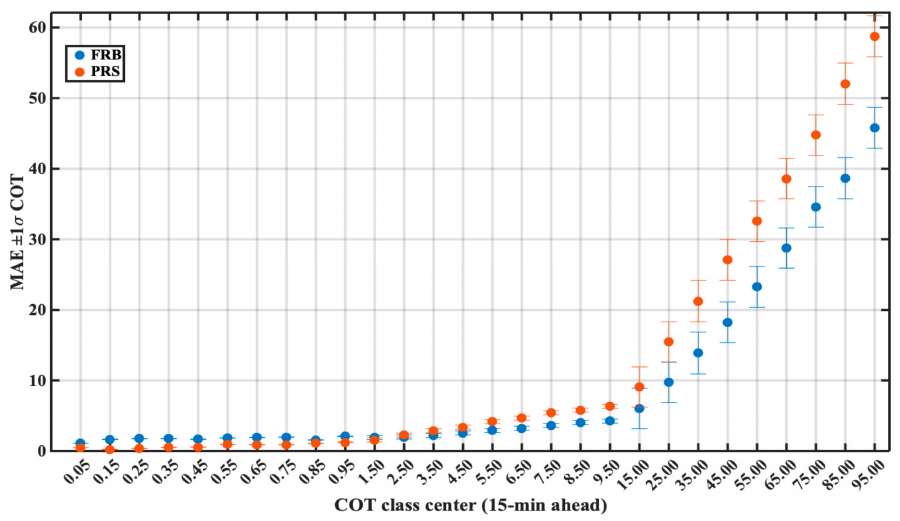
Figure 11. Classification of PRS and forecasted COT in terms of MAE ± 1 σ for the 15 min forecast time